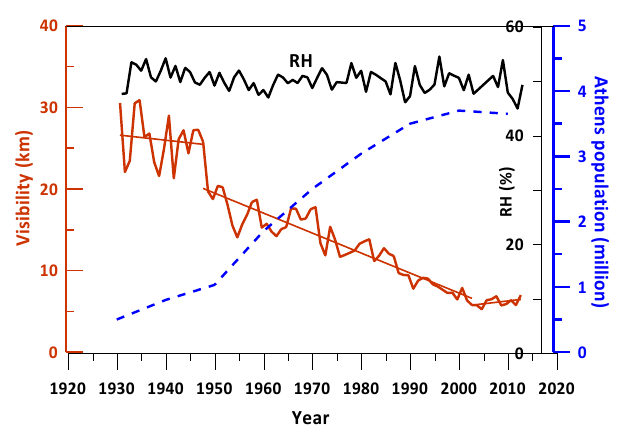
Figure 4. Interdecadal variability of the annual visibility in Athens from 1931 to 2013, along with linear trends for three subperiods: 1931–1948, 1949–2003 and 2004–2013 (red line). The dashed blue line illustrates the population growth in Athens (in millions) since 1930 (Founda, 2011). The long-term variability of the annual rela- tive humidity (RH) in Athens is also shown (upper black line).